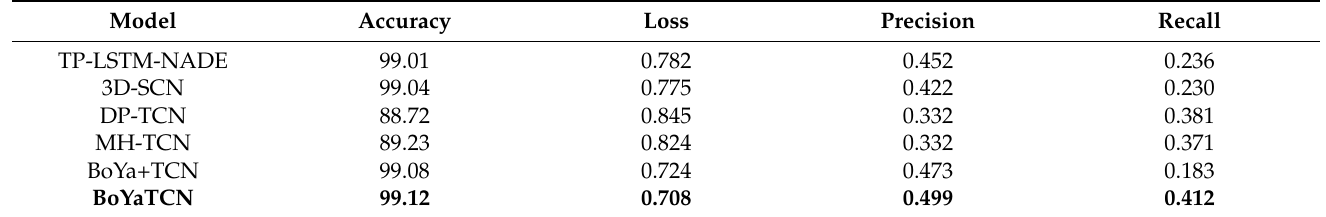
Table 4. Comparison of objective machine learning metrics for ablation experiments based on three-dimensional sequential convolutional